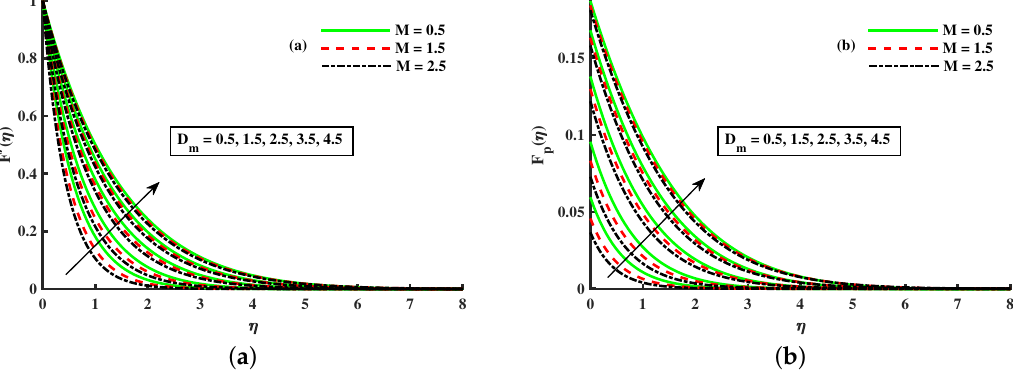
Figure 3. Fluctuation of M and D m on F (cid:48) ( η ) ( a ) and the effect of M and D m on F p ( η ) ( b ).